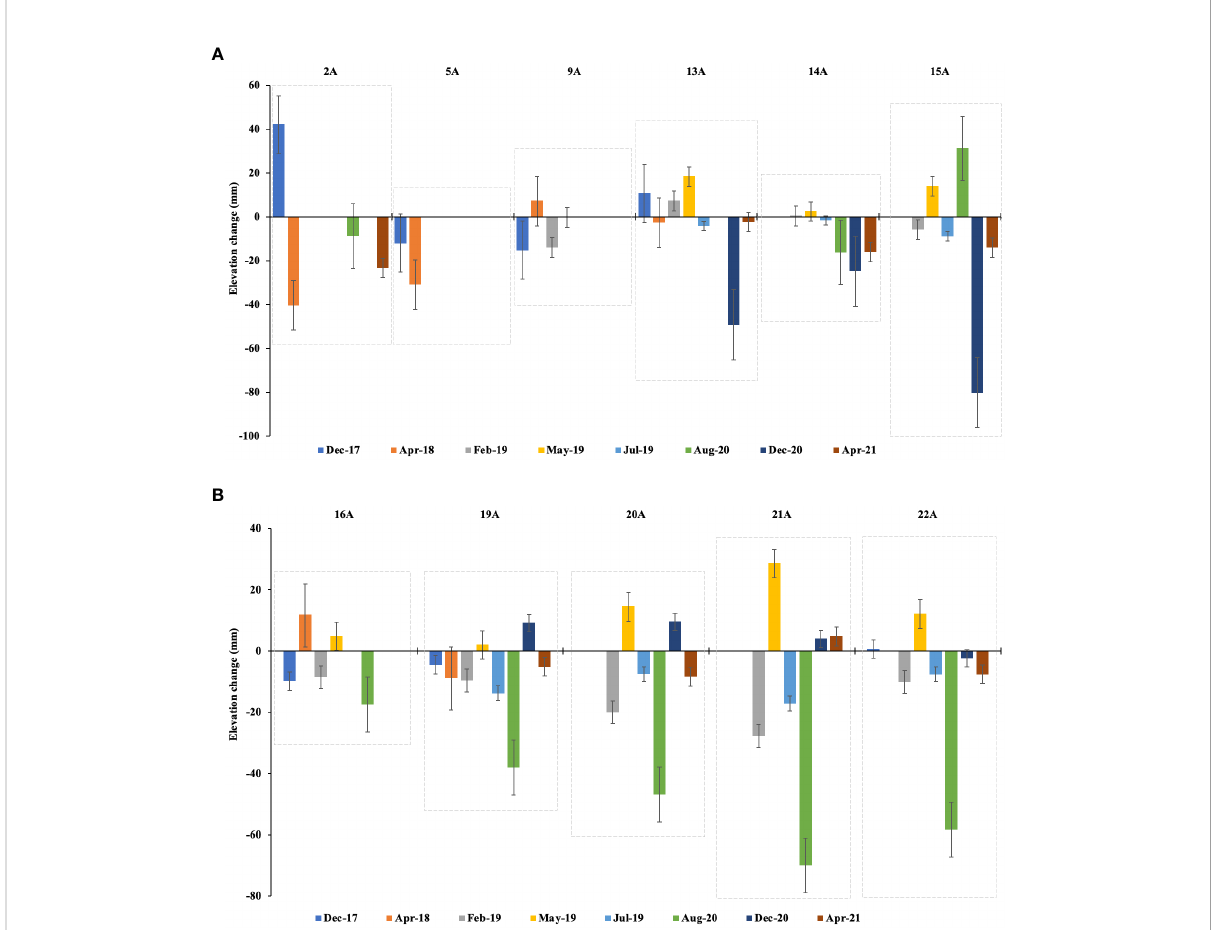
FIGURE 6 Mangrove surface elevation changes measure between Dec 2017 and April 2022 close to the main creek channel within the mangroves of Vanga at (A) stations 2A, 5A, 9A, 13A, 14A and 15A and (B) stations 16A, 19A, 20A, 21A and 22A. The top x-axis represents the stations, while the bottom x-axis is the monitoring time stamps. Error bars represent the standard